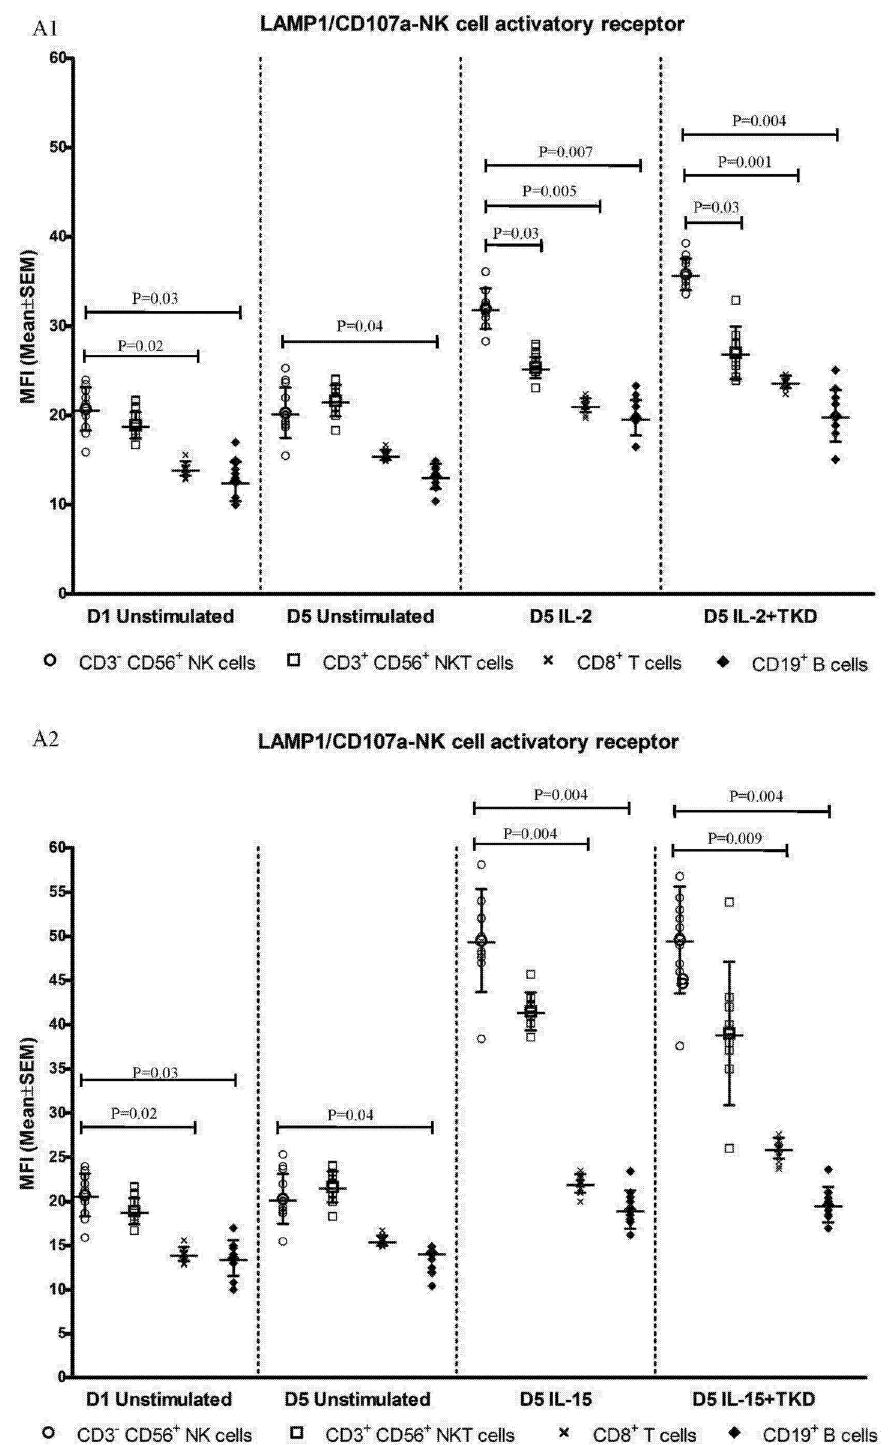
Fig 20. The effect of IL-2, IL-15, IL-2/TKD and IL-15/TKD on the expression of LAMP1 in peripheral blood mononuclear cells of healthy individuals — the amount of receptor expressed by CD3 - CD56 + NK cells, CD3 + CD56 + NKT cells, CD8 + T cells and CD19 + B cells (the median fluorescence intensity). The amount of LAMP1 expressed by CD3 - CD56 + NK cells, CD3 + CD56 + NKT cells, CD8 + T cells and CD19 + B cells was examined within the fraction of unstimulated and stimulated mononuclear cells derived from